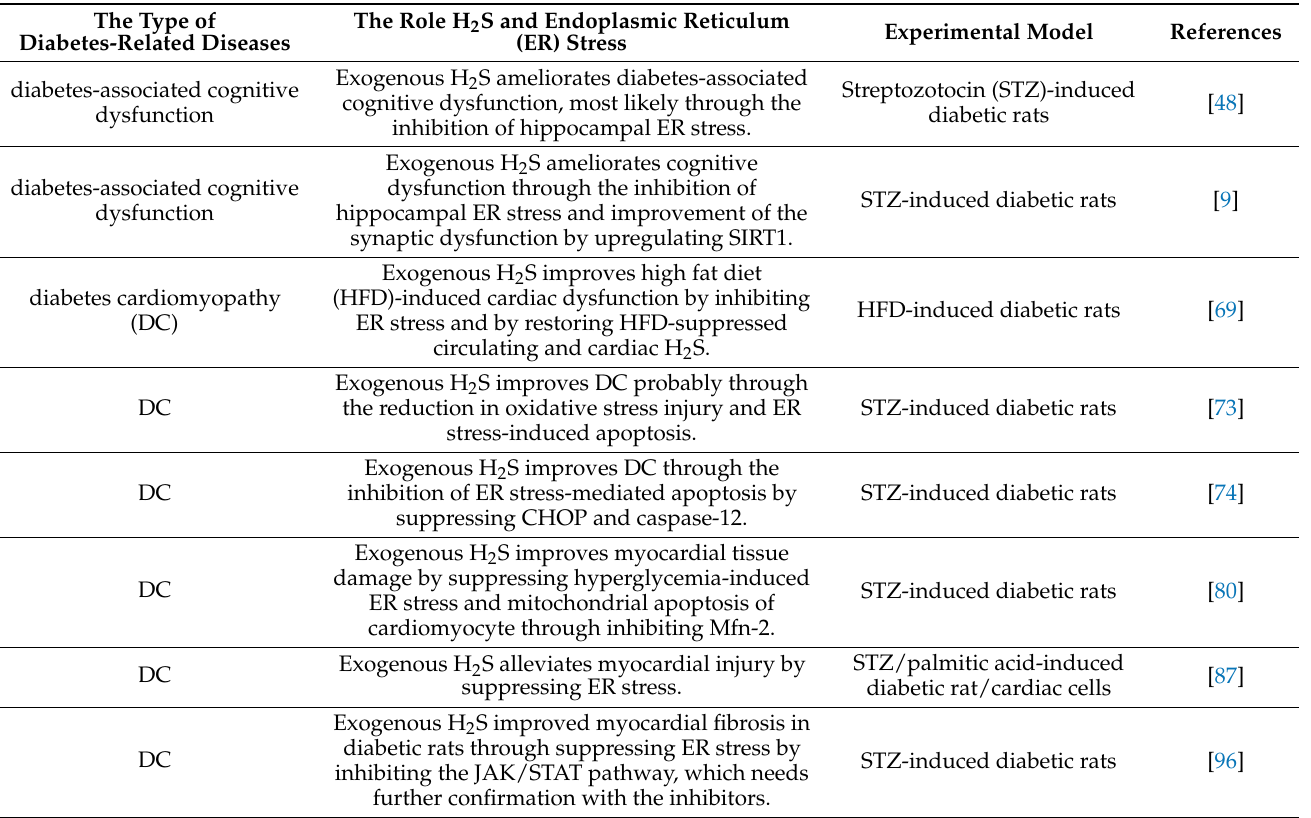
Table 1. The summary of the role of H 2 S regulation of endoplasmic reticulum stress in diabetes- related